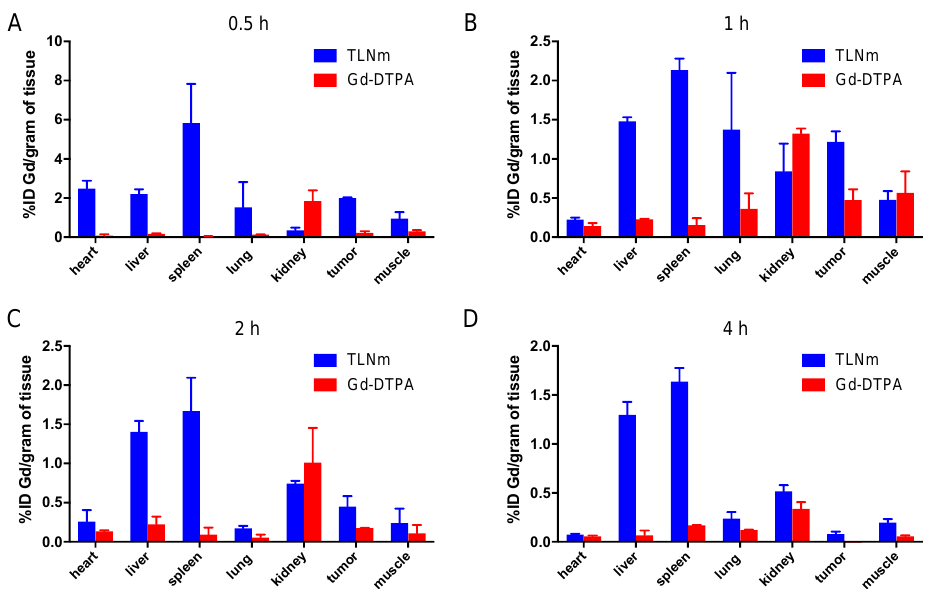
Figure 5. Ex vivo gadolinium biodistribution in HepG2 tumor-bearing mice at 0.5 h ( A ), 1 h ( B ), 2 h ( C ), and 4 h ( D ) post-injection of Gd-DTPA and TLNm, respectively (dose: 0.1 mol Gd/kg).